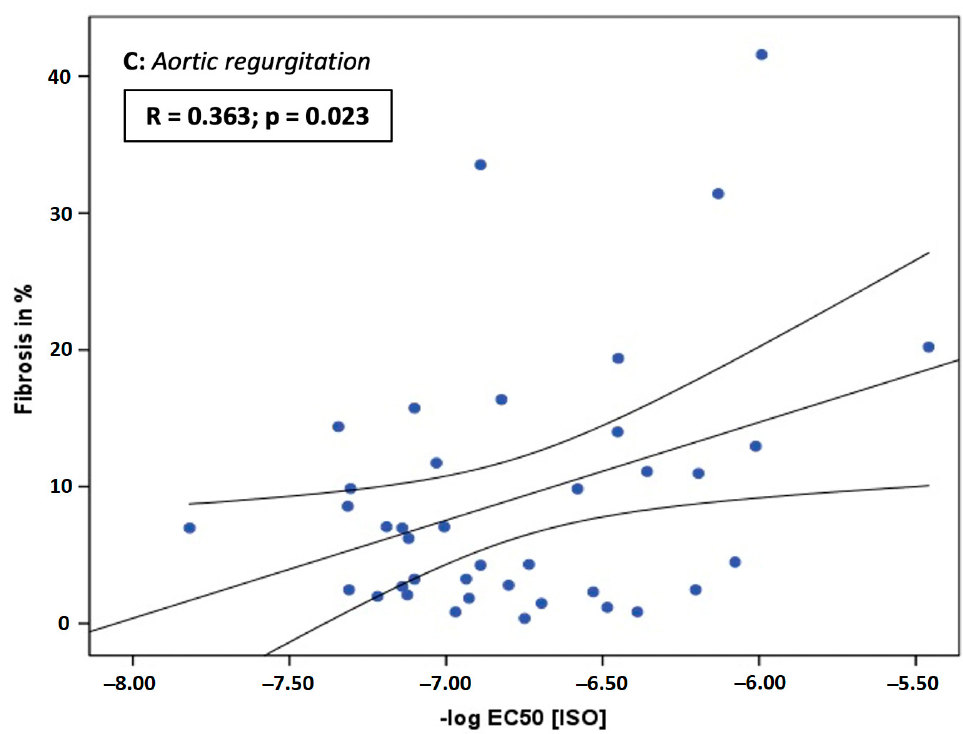
Figure 3. Correlation of fibrosis (in%) with Beta-AR sensitivity ( − log EC 50 [ISO]) in the whole study cohort (n = 93) ( A ) and in subgroups with stenosis ( B , green) and regurgitation ( C , blue)